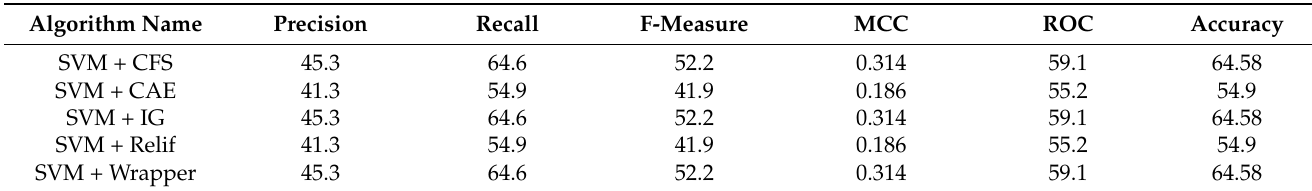
Table 17. Comparison among feature extraction algorithms using SVM classifier to predict the total critical cases.